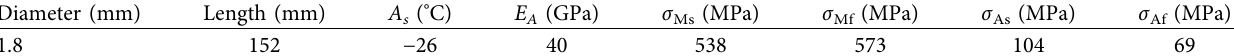
Table 1: Mechanical properties of the superelastic SMA [35].